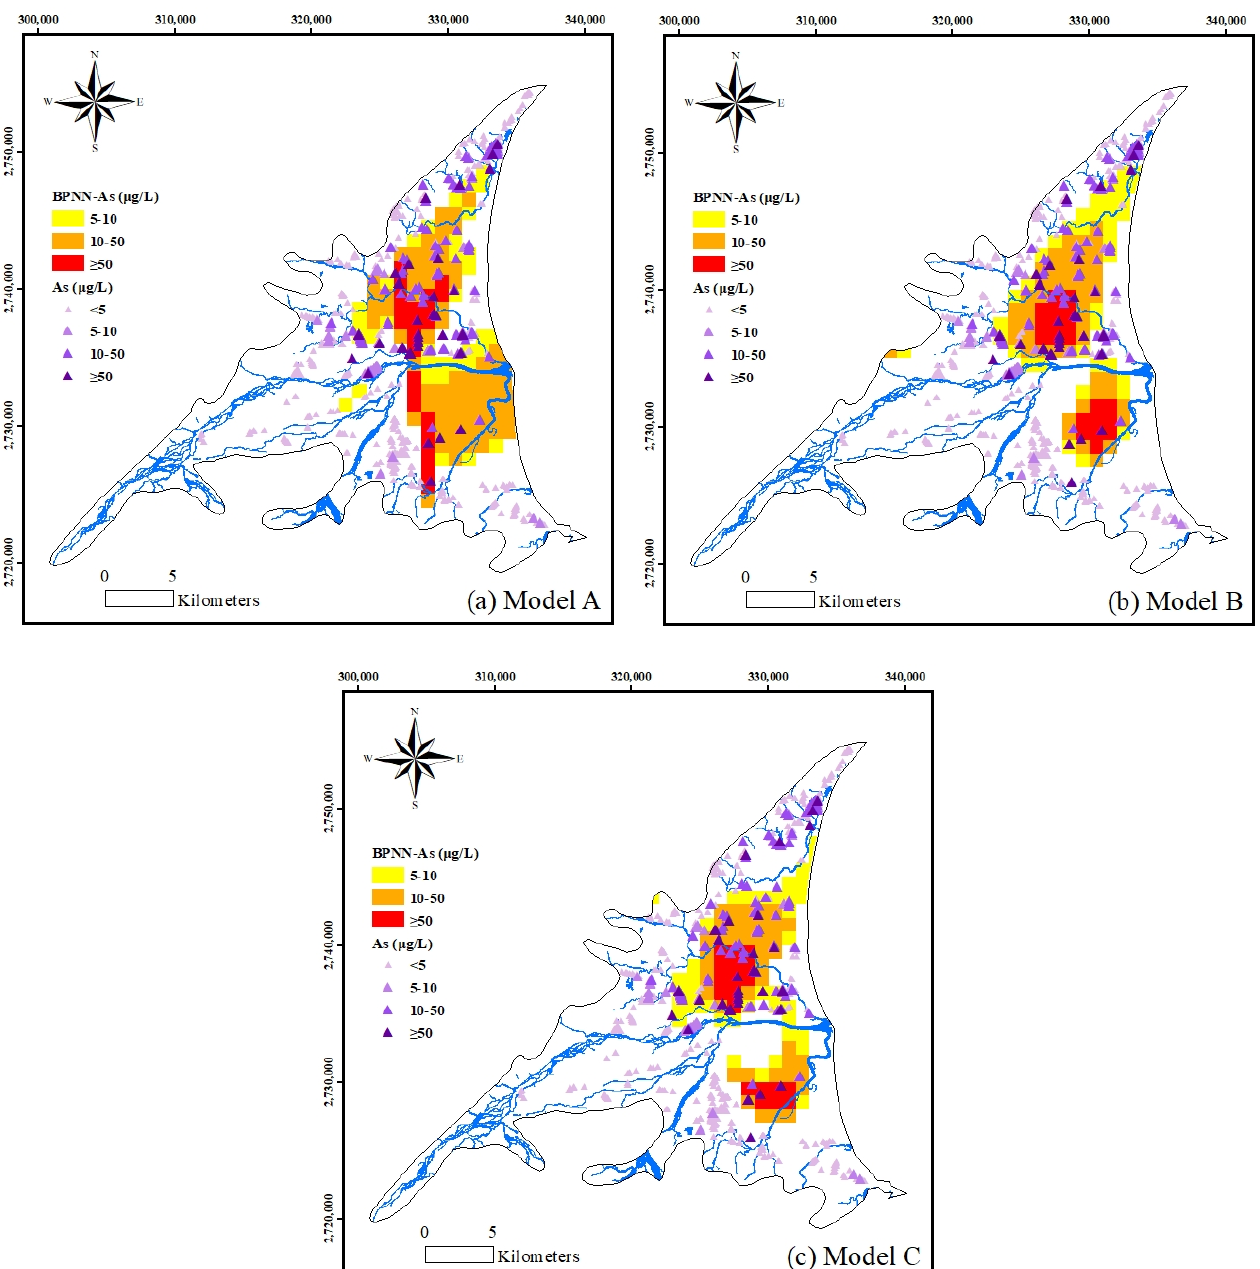
Figure 5. Spatial mapping of unacceptable As concentrations estimated by BPNN.